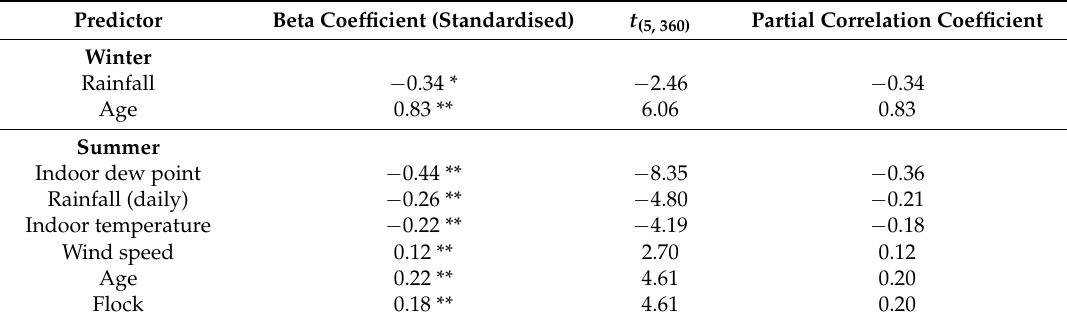
Table 4. Multiple regression analysis on the number of chickens on the range daily in winter, and hourly in summer (adjusted r 2 = 0.76 and 0.35 in winter and summer, respectively). Only variables that significantly contributed to the most parsimonious model are